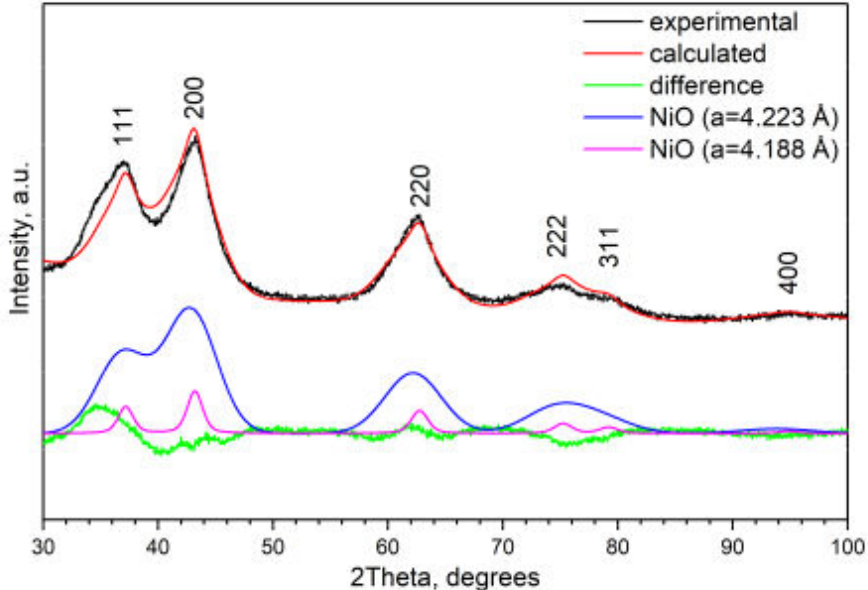
Figure 8. Rietveld analysis of two NiO cubic phases with different lattice constants (the first peak was excluded from the